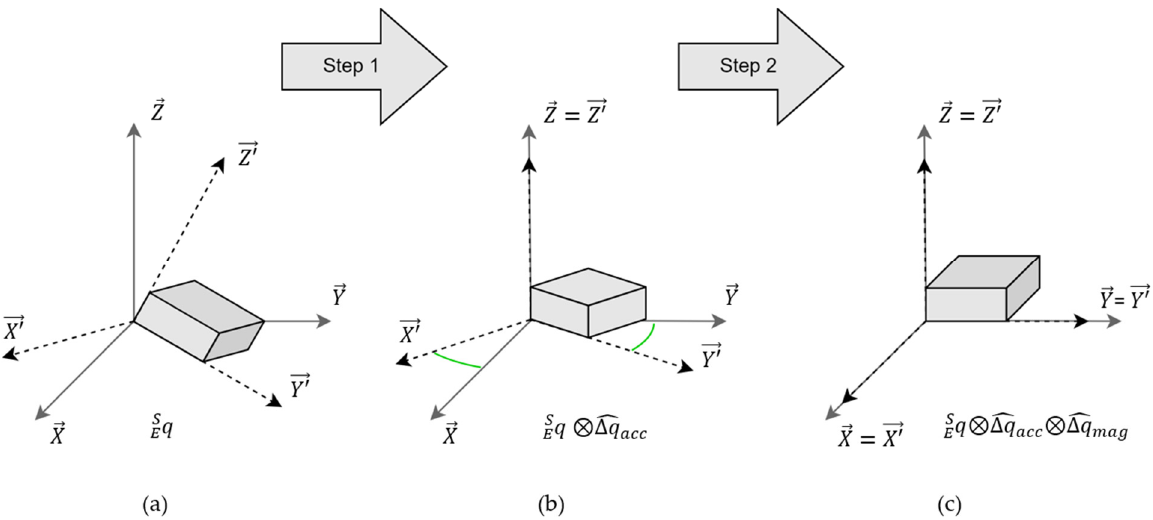
Figure 3. The schematic of orientation estimation-solving with the two-step complementary filter: ( a ) is the initial orientation of the sensor, with the sensor frame 𝑅 (cid:3014)(cid:3010)(cid:3014)(cid:3022) = (cid:3435)𝑋 (cid:4593) (cid:4652)(cid:4652)(cid:4652)(cid:4652)⃗ , 𝑌 (cid:4593) (cid:4652)(cid:4652)(cid:4652)⃗ , 𝑍 (cid:4593) (cid:4652)(cid:4652)(cid:4652)⃗ (cid:3439) in the Earth frame 𝑅 (cid:3032)(cid:3028)(cid:3045)(cid:3047)(cid:3035) = (cid:3435)𝑋⃗,𝑌(cid:4652)⃗, 𝑍⃗(cid:3439) ; ( b ) shows the first correction on the attitude, with the delta quaternion, ∆𝑞(cid:3554) (cid:3028)(cid:3030)(cid:3030) ; ( c ) shows the second correction on the heading, with the delta quaternion, ˆ ∆ q